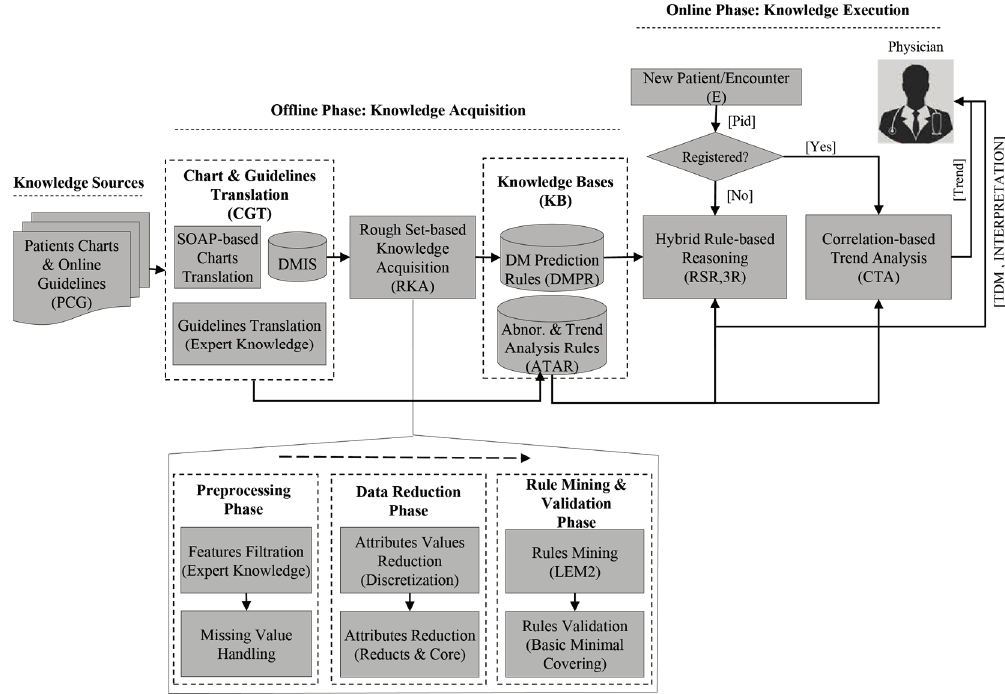
Figure 1. Hybrid rough set reasoning model for prediction and management of diabetes